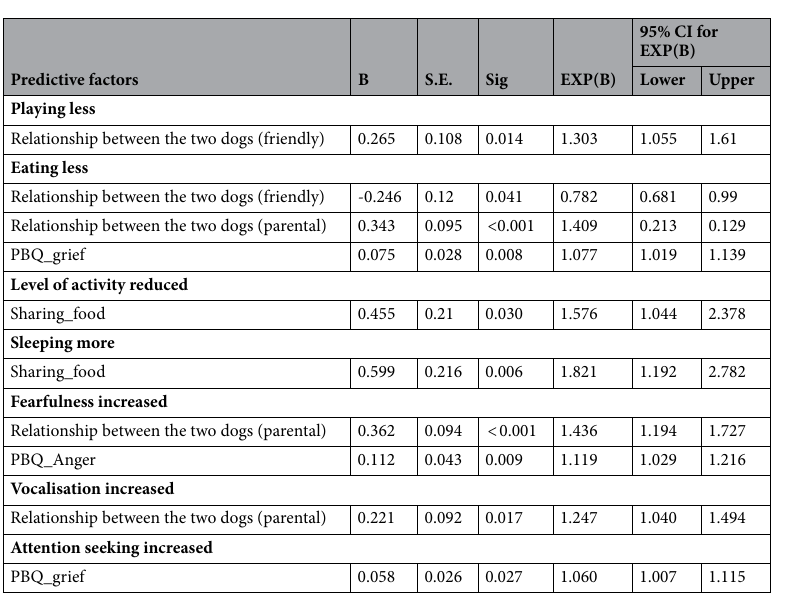
Table 5. Multiple logistic regression model predicting dog behaviour’s changes. B regression coefficient, S.E. standard error, Sig. significance, EXP(B ) exponentiation of the B coefficient (odds ratio), CI confidence